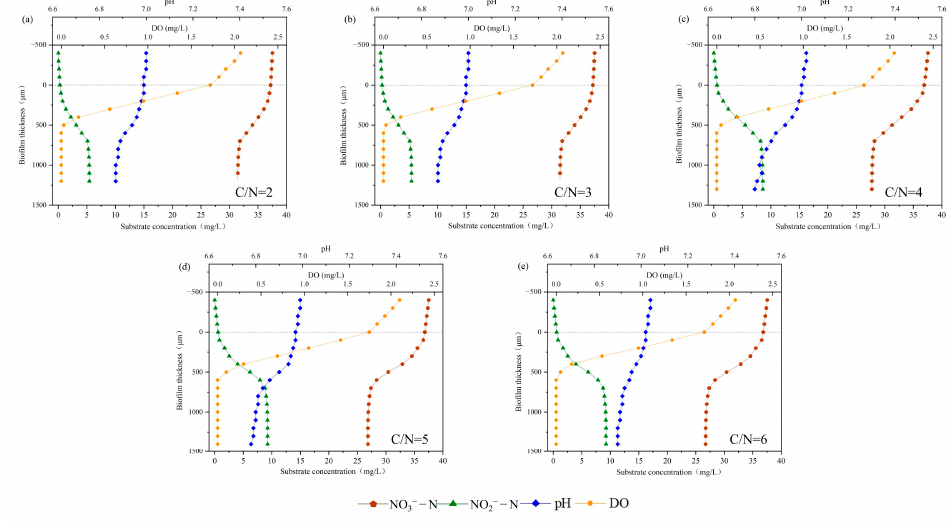
Figure 5. Biofilm thickness and the variation of substrate at different influent C/N: ( a ) 2; ( b ) 3; ( c ) 4; ( d ) 5; ( e ) 6. ( d ) 5; ( e )